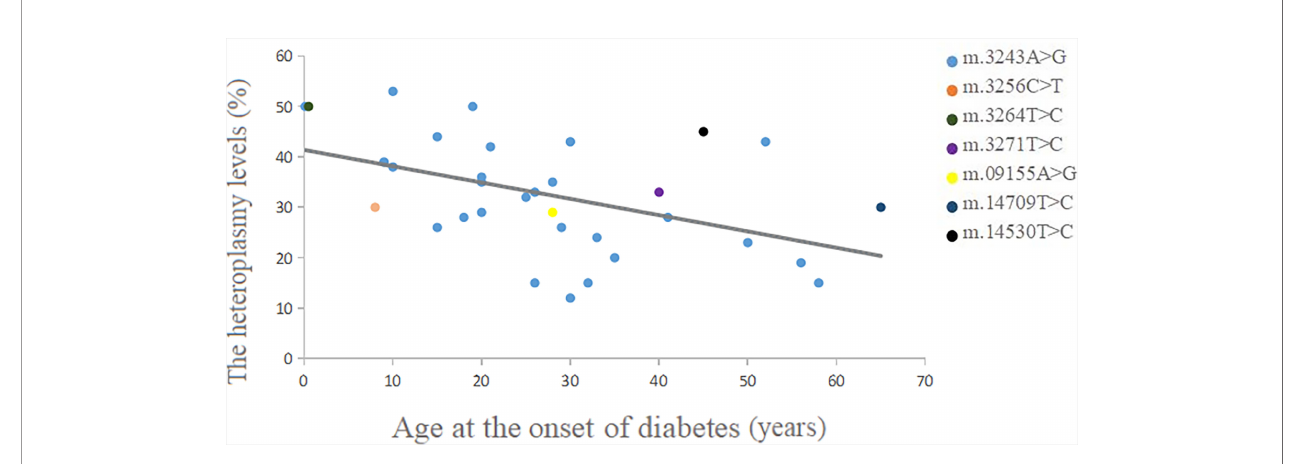
FIGURE 4 | Correlation between blood heteroplasmy levels and age at the onset of diabetes.